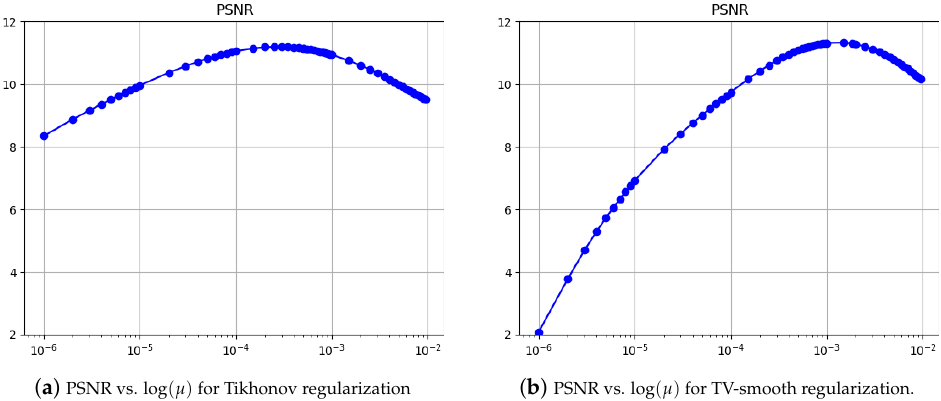
Figure 3. Motivation for the choice of the Stage 2 regularization parameters µ . ( a , b ) show the PSNR as functions of log ( µ ) for Tikhonov and TV-smooth regularization, respectively. The curves were obtained from the vessel-shaped phantom keeping the Stage 1 parameter fixed at λ =